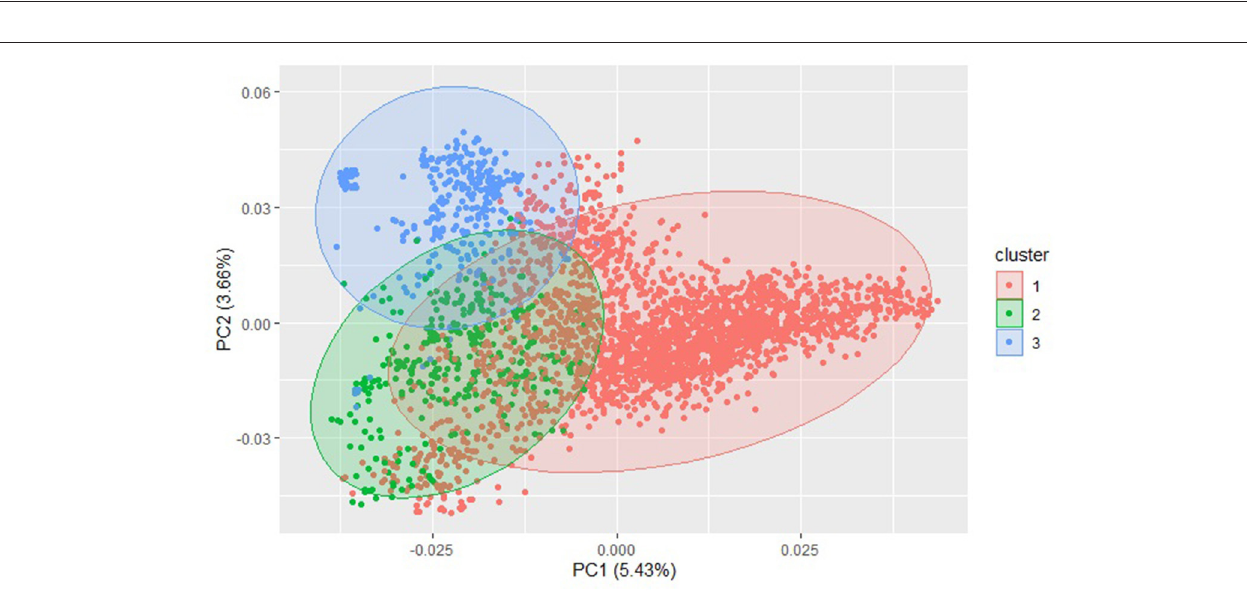
FIGURE 3 | Principal component (PC) biplot and k -means clustering of single-nucleotide polymorphism (SNP) genotyped-by-sequencing (GBS) markers from the diversity panel (DP) lines and breeding lines (BL) training populations.